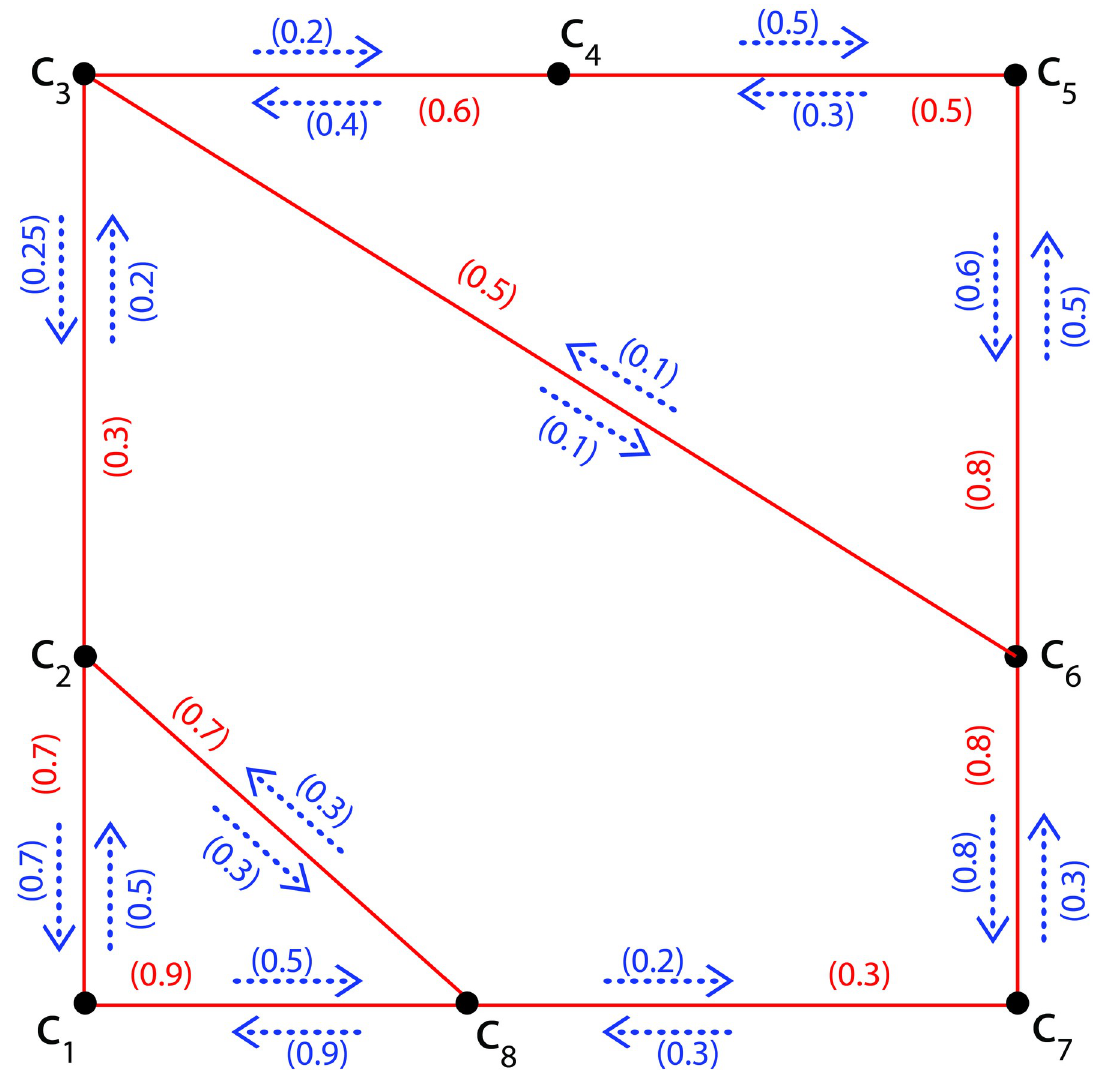
Fig 9. A highway system of different